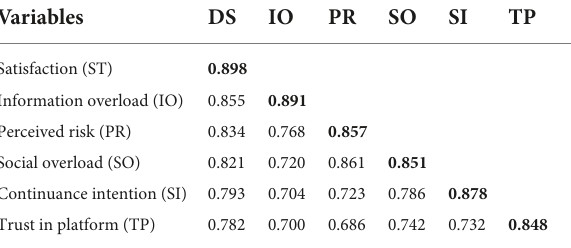
TABLE 5 Presenting the HTMT